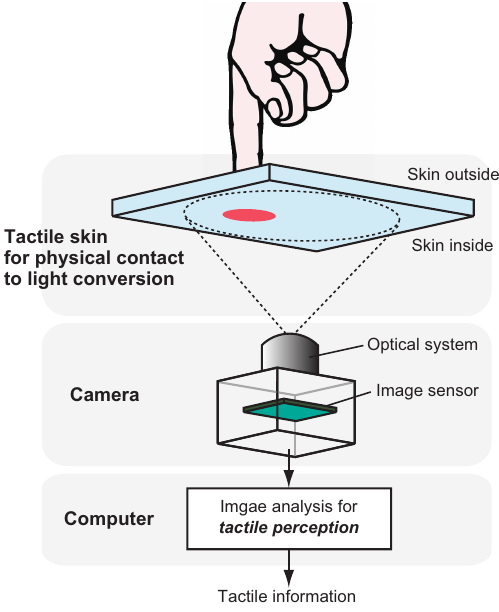
Figure 1. Typical structure of a tactile imaging sensor employing a camera. A tactile skin with a contact-light conversion mechanism somehow converts physical tactile stimuli into light signals, that can be captured by the camera. In a camera, an optical system that includes a lens determines spatial measurement range. The spatial resolution and the temporal resolution are determined by the specification of the image sensor. The image sequence, that is captured by the camera, is analysed by the computer on which the image processing software is running to extract tactile